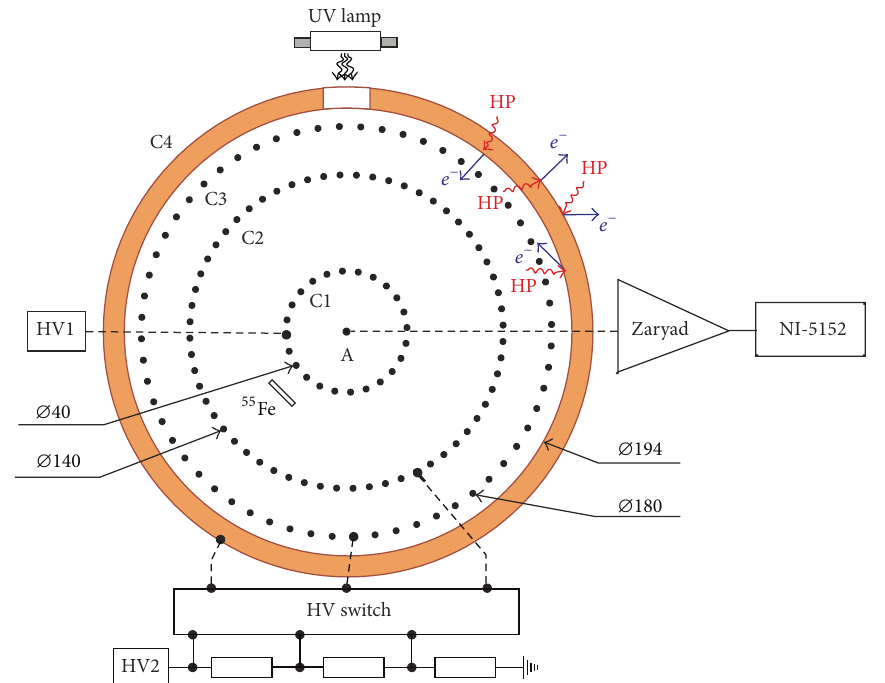
Figure 2: A simplified electronic scheme of a multicathode counter (MCC). A: anode, C1–C4: cathodes, and “Zaryad”: charge sensitive preamplifier.